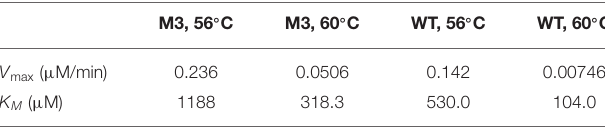
TABLE 4 | Kinetic parameters of EP-B2 variant “M3” and the wild type (WT) control was determined using a synthetic substrate, Z-Phe-Arg-pNA.